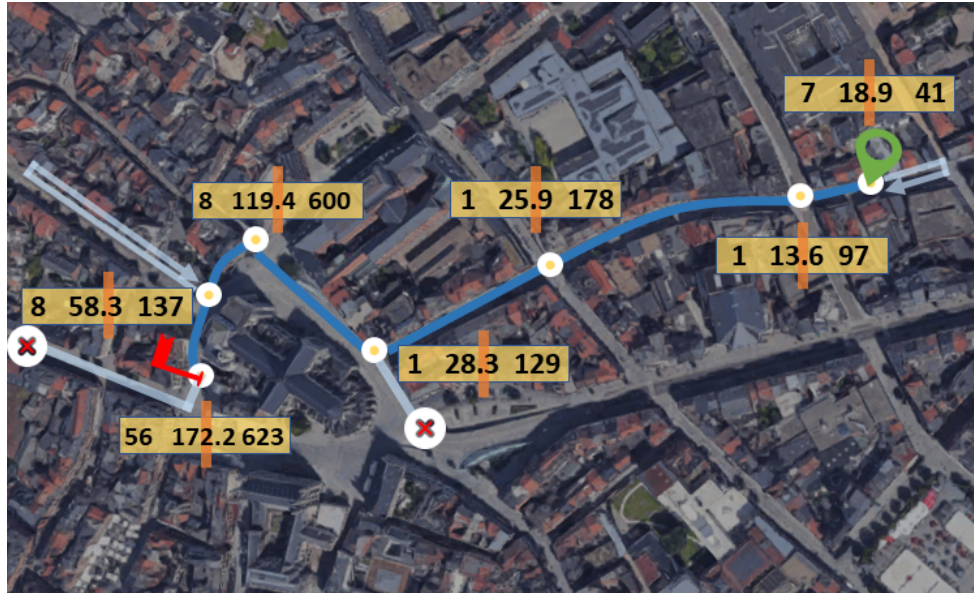
Figure 12. Task completion overview. See text for explanation.